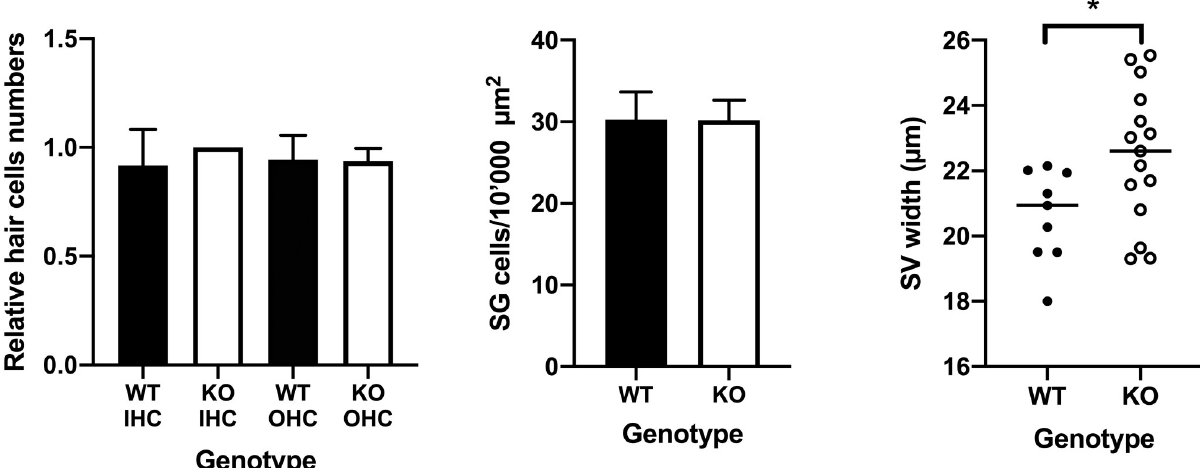
Fig 6. No loss of HC and SG cells in 12–13 weeks old mice. (A) Comparison of the relative cell numbers of inner hair cells (IHC) and outer hair cells (OHC) between wild type (WT) and STAT1-KO mice (KO). (B) Comparison of spiral ganglion (SG) cells between WT and STAT1-KO mice. (C) Comparison of the stria vascularis (SV) thickness between WT and STAT1-KO mice. STAT1-KO mice show slight thickener membrane as those from the WT mice. Two tailed student’s t -test was used to compare two genotype groups. � P <